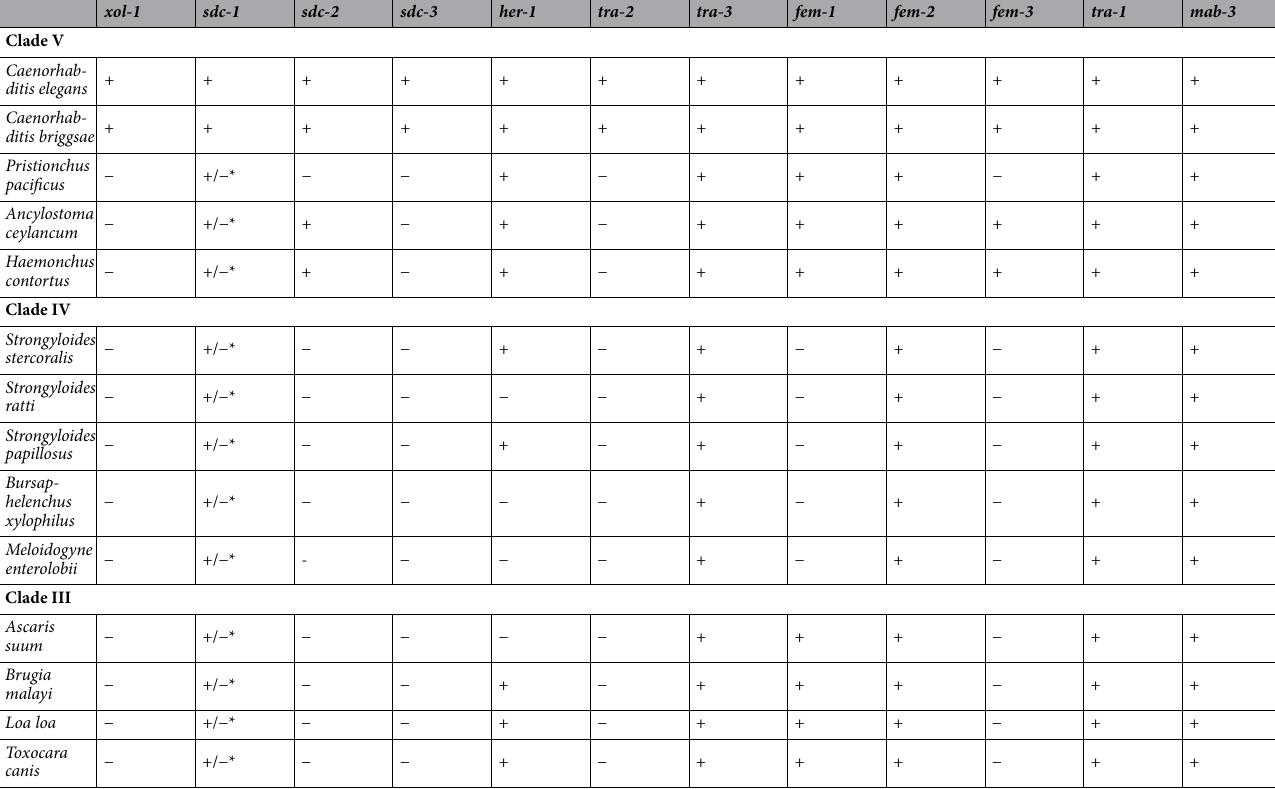
Table 2. Homologs of genes involved in Caenorhabditis sex determination in representative clade III, IV, and V nematodes. *Unclear whether these homologs are more similar to Caenorhabditis elegans sdc−1 or C04F5.9